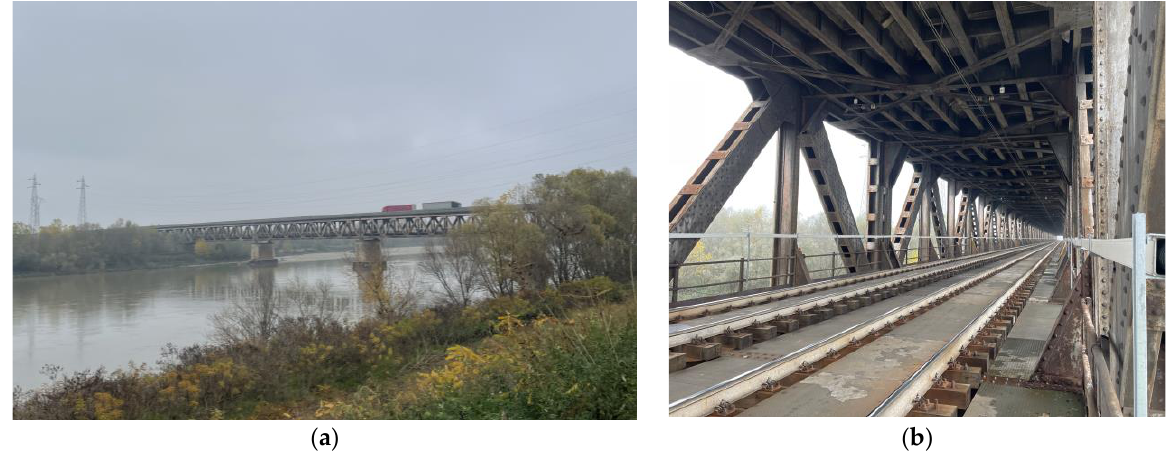
Figure 4. The Bressana bridge on the Po river: ( a ) Lateral view of the bridge crossing the river with heavy vehicles running on the upper deck; ( b ) internal view of the lower deck reserved to railway traffic.